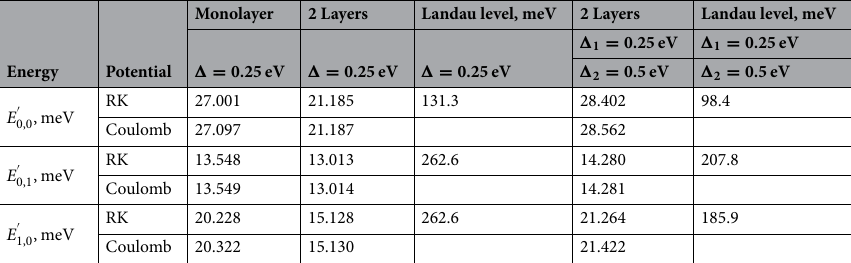
Table 1. Calculations performed for the monolayer strained and gapped graphene, (cid:31) = 0.25 eV, and for a double layer strained graphene with the gap (cid:31) = 0.25 eV in one layer and (cid:31) = 0.50 eV in the other. The value of magnetic length l corresponds to B / e = 50 T. Two strained and gapped graphene layers are separated by D = 1.7 nm by the dielectric with ε = 13 .